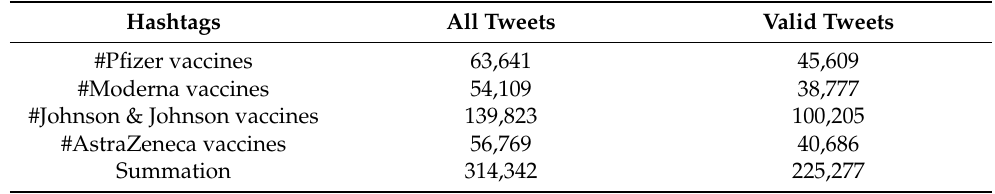
Table 1. List of Hashtags Related to the COVID-19 Vaccination. Hashtags All